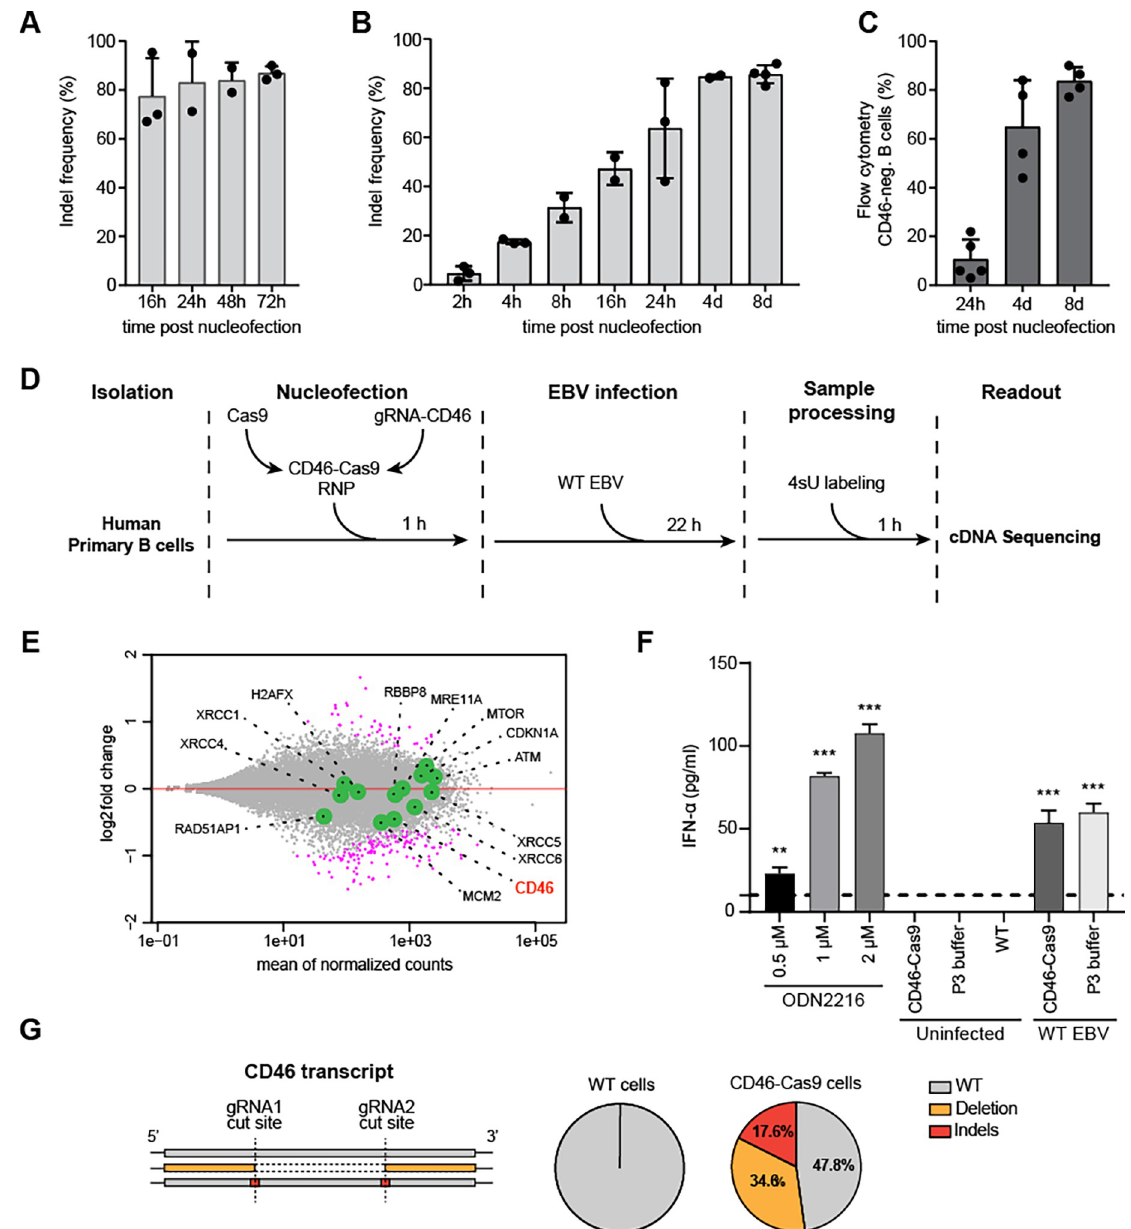
Fig 2. The kinetics of induced DNA breaks and their repair in the second exon of CD46 in non-infected and EBV-infected primary human B cells. (A) Primary human B cells were nucleofected with the two CD46-Cas9 RNP complexes and analyzed 16, 24, 48 and 72 hours later. The cells were left non-infected. At the indicated time points viable cells were selected by Ficoll gradient centrifugation. Part of the CD46 locus in their cellular DNA was amplified in a two level PCR barcoding scheme prior to next generation sequencing. Data were analyzed using the Outknocker 2.0 web tool. The results showed a indel frequency of 70% in primary human B cells 16 h after nucleofection in the absence of EBV infection. Indel frequencies increased up to 90% 72 h after nucleofection. Mean and standard deviation of independent biological replicates are shown. (B) The time course experiments show the indel frequencies in the second exon of CD46 in EBV infected primary B cells after nucleofection with two CD46-Cas9 RNP complexes. Cellular DNA of viable cells was amplified in a two level PCR barcoding scheme prior to next generation sequencing and the data were analyzed with the Outknocker 2.0 web tool. Indel frequencies increased up to 85% 8 days after nucleofection. Mean and standard deviation of independent biological replicates are shown. (C) CD46 flow cytometry analyses of primary B cells 1, 4 and 8 days after nucleofection with two CD46-Cas9 RNP complexes and subsequent infection with WT EBV are shown. Mean and standard deviation of independent biological replicates are provided. (D) Scheme of metabolic labeling of newly transcribed RNAs with 4sU and their analysis by next generation sequencing. 2 × 10 7 primary human B cells were nucleofected with two CD46-Cas9 RNP complexes. Nucleofected (CD46-Cas9) as well as adjusted numbers of untreated (WT) B cell